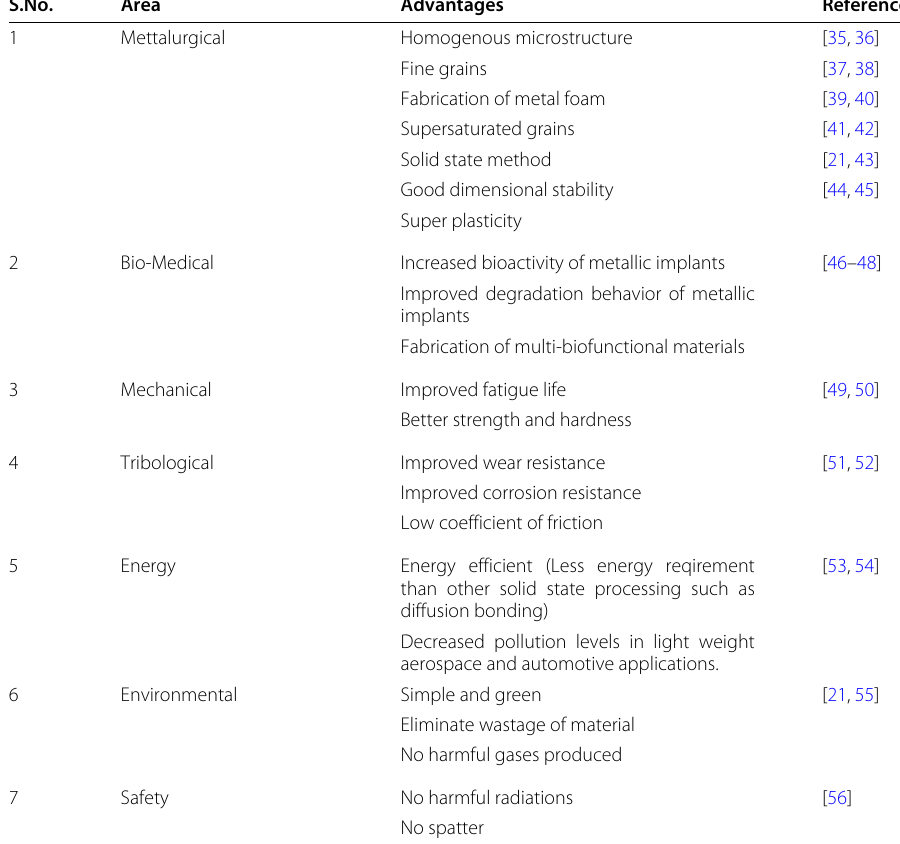
Table 1 Advantages of FSP